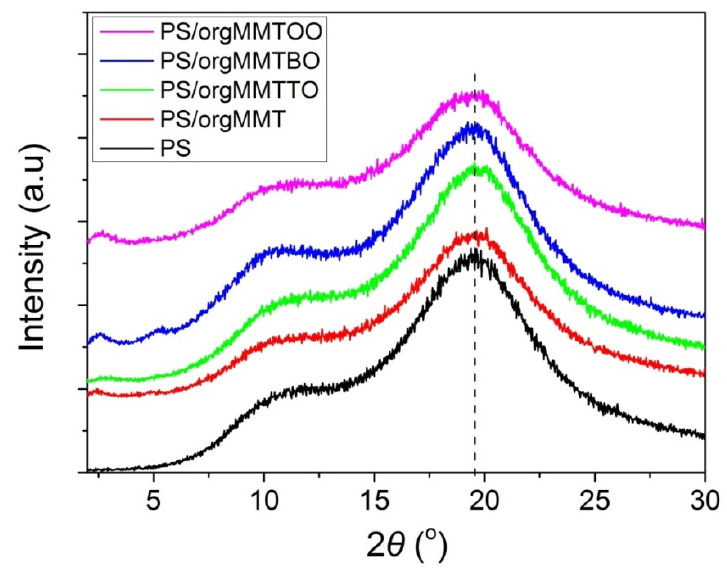
Figure 1. X-ray diffraction patterns of neat polystyrene (PS) and its nanocomposites with 3% orgMMT, orgMMTBO, orgMMTTO and orgMMTOO over the full range of 2 θ from 2 to 30°.